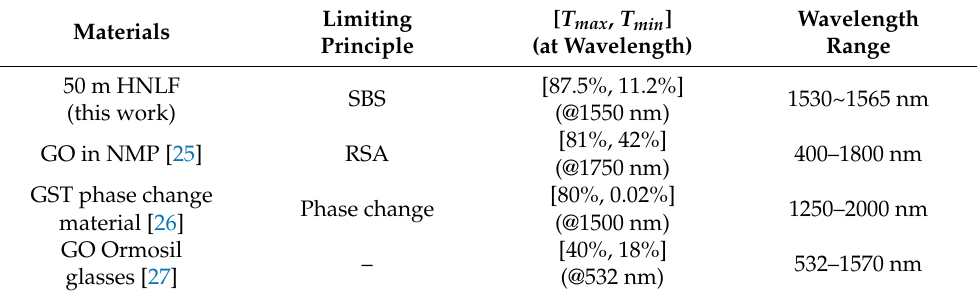
Table 2. Comparison of different infrared broadband NOL